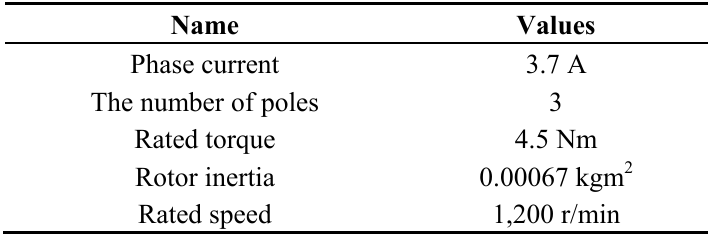
Table 1. Specification of the